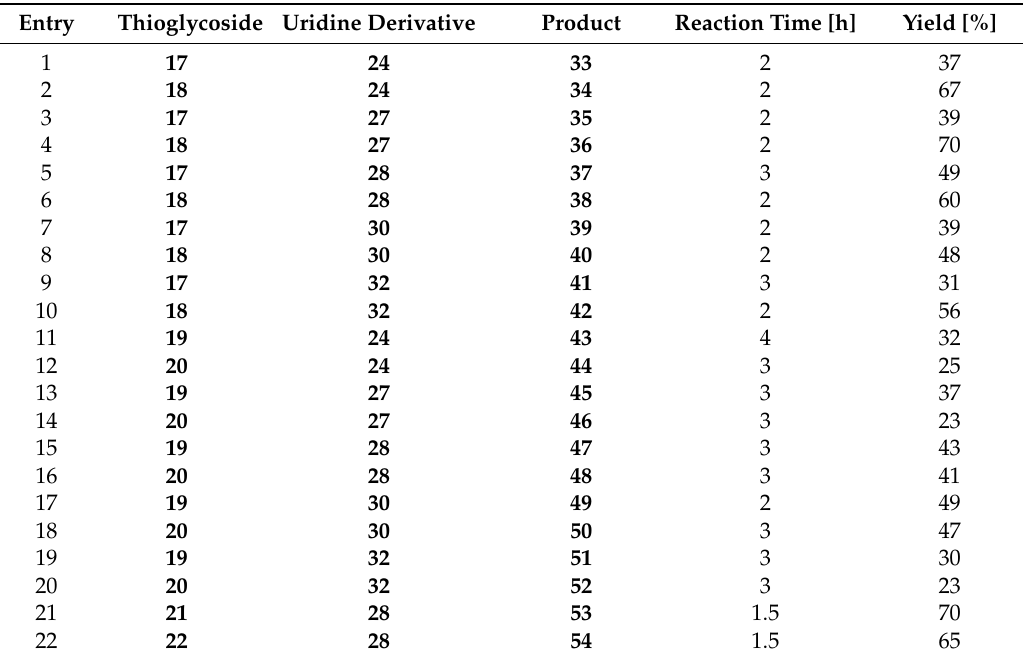
Table 2. Yields of glycoconjugates 33 –